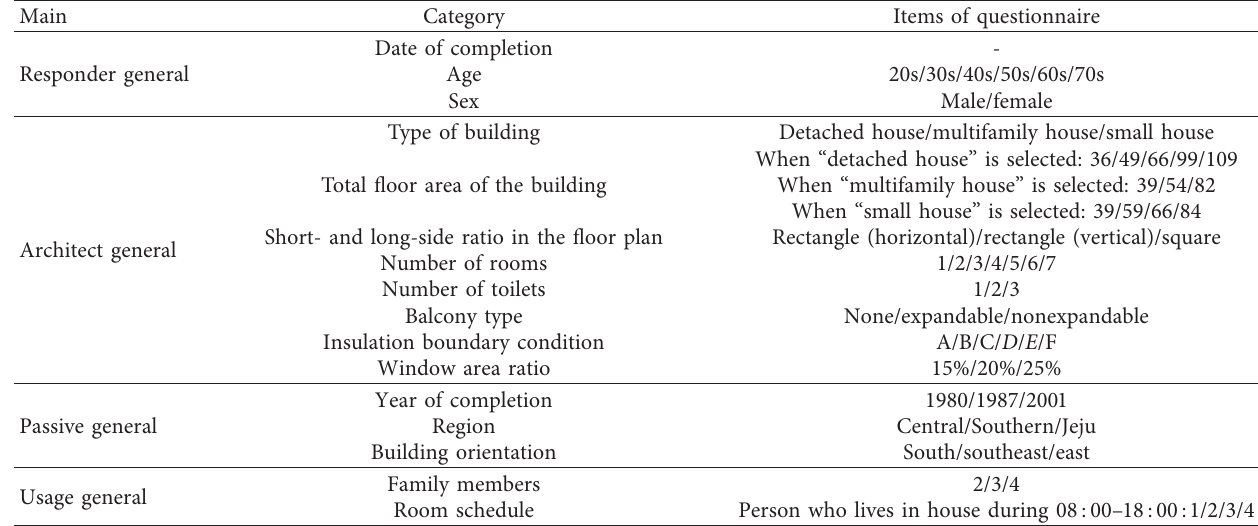
Table 12: Variables for Survey